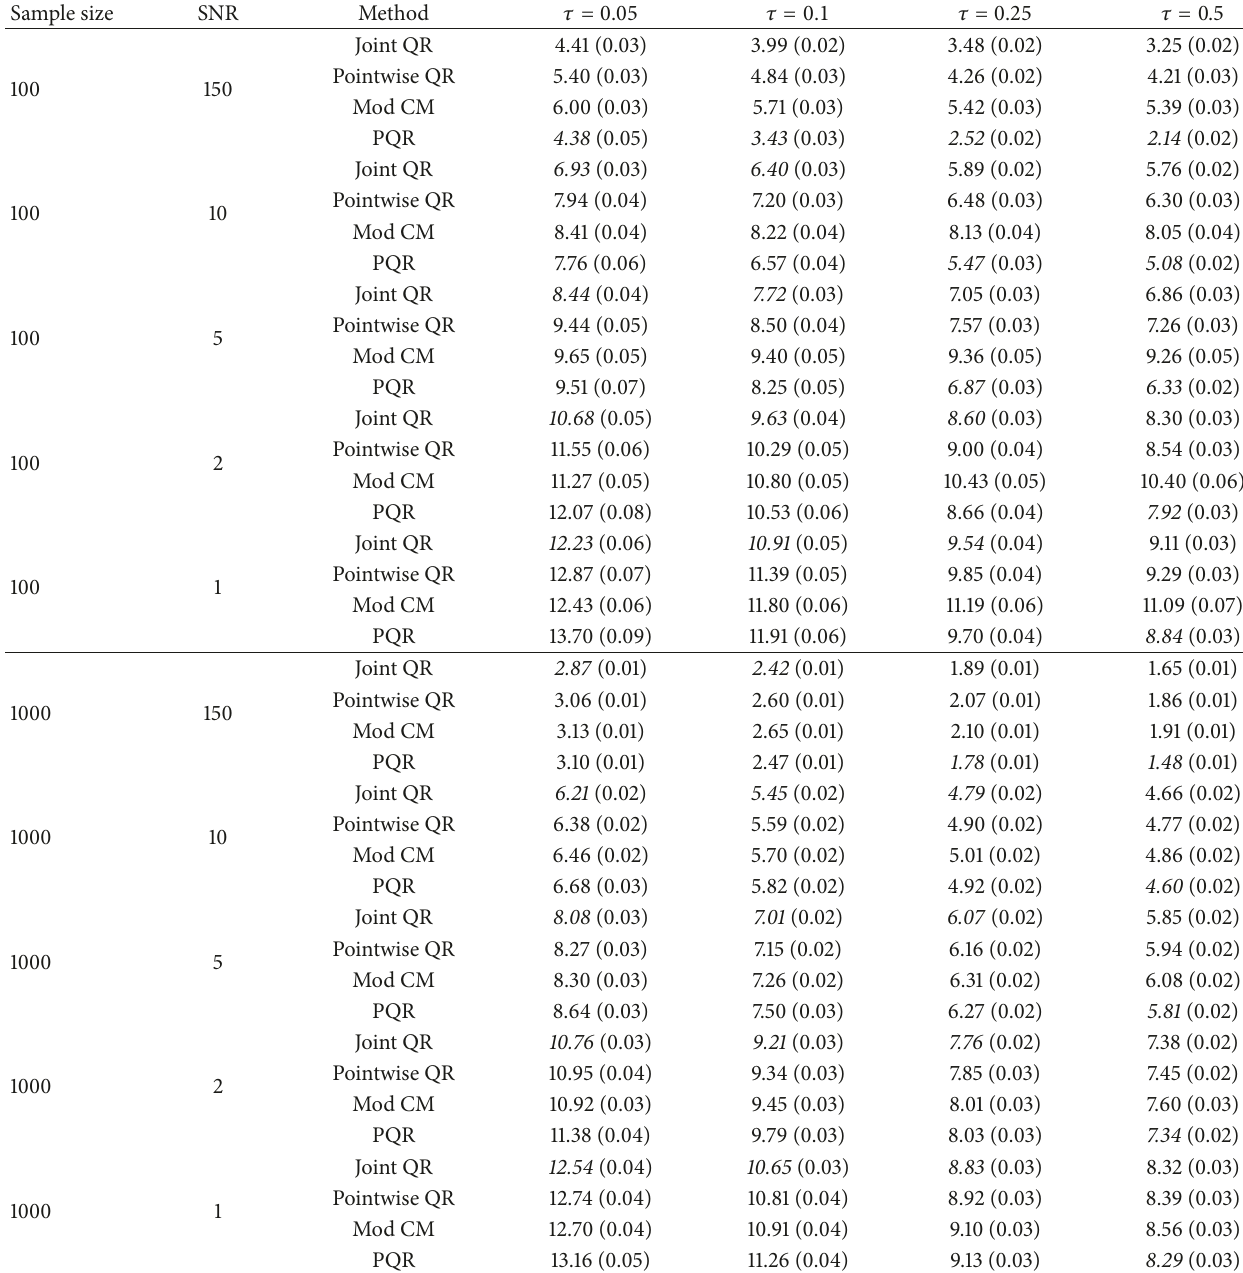
Table3:AverageMAE(standarderrorinparentheses)ofthepredicted 𝜏 -levelquantileforthecaseofheteroskedasticitywithascalarcovariate and a sparsely observed functional covariate.